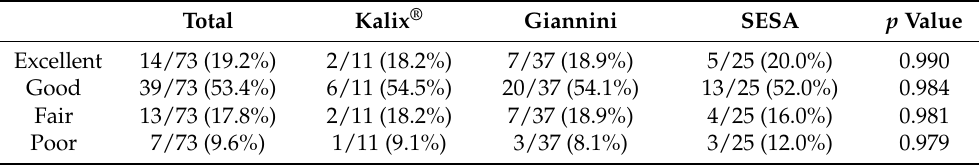
Table 2. Treatment